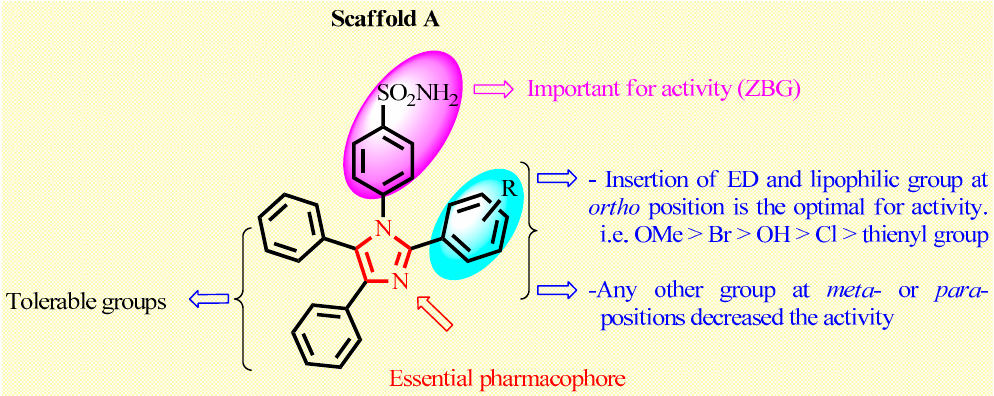
Figure 2. Rational design and structural modification of Scaffold A .